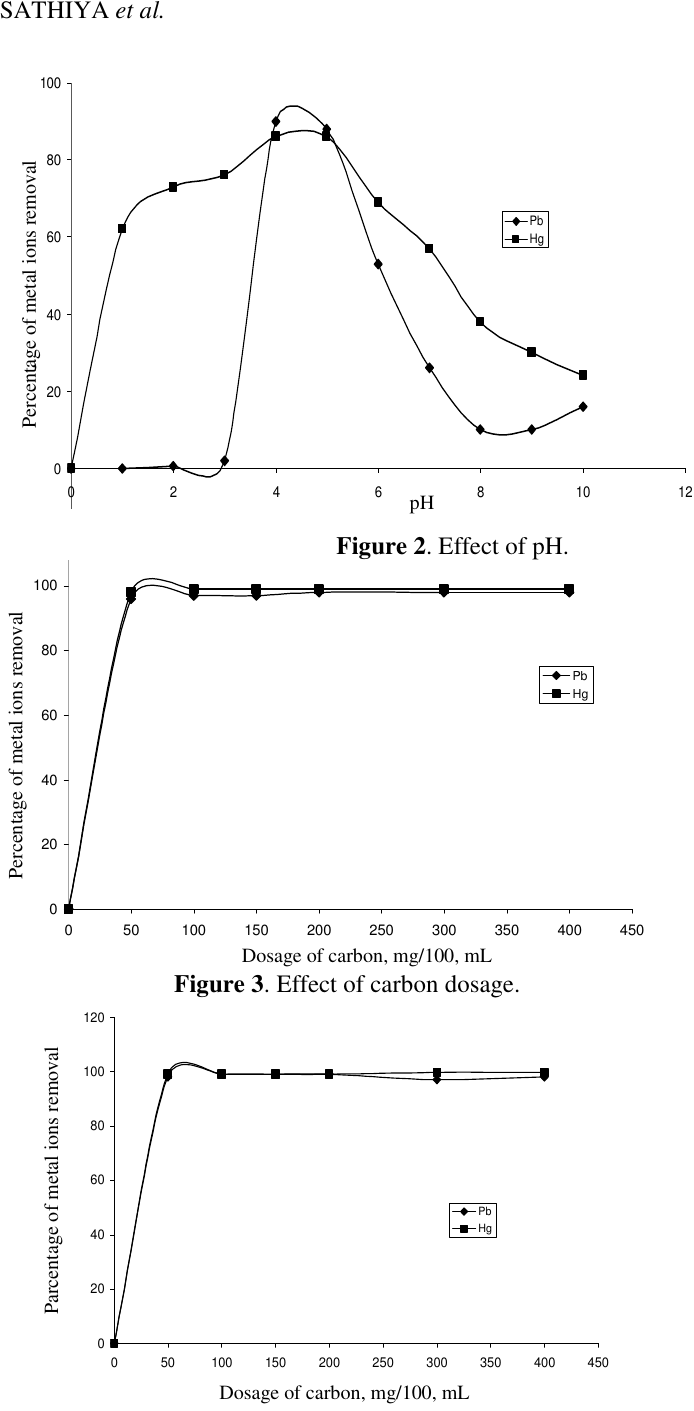
Figure 4 . Effect of carbon dosage (1:2) for Pb:Hg